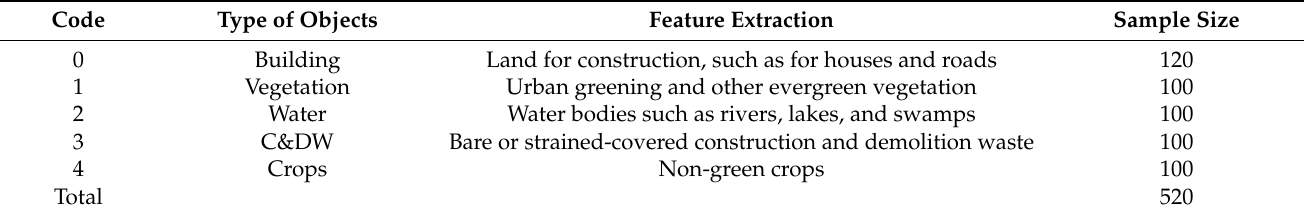
Table 2. Sample data selected in this study. A total number of 520 samples were generated as the training dataset for the machine learning methods. C&DW: construction and demolition